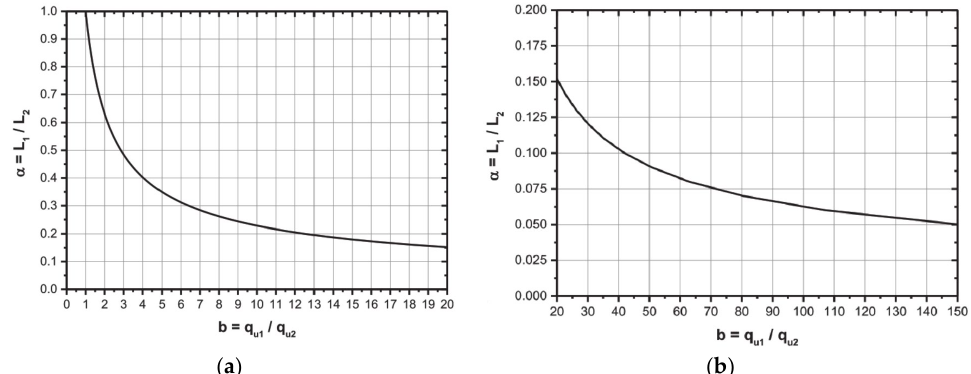
values between 0 and 20, ( b ) diagram for 𝑏𝑏